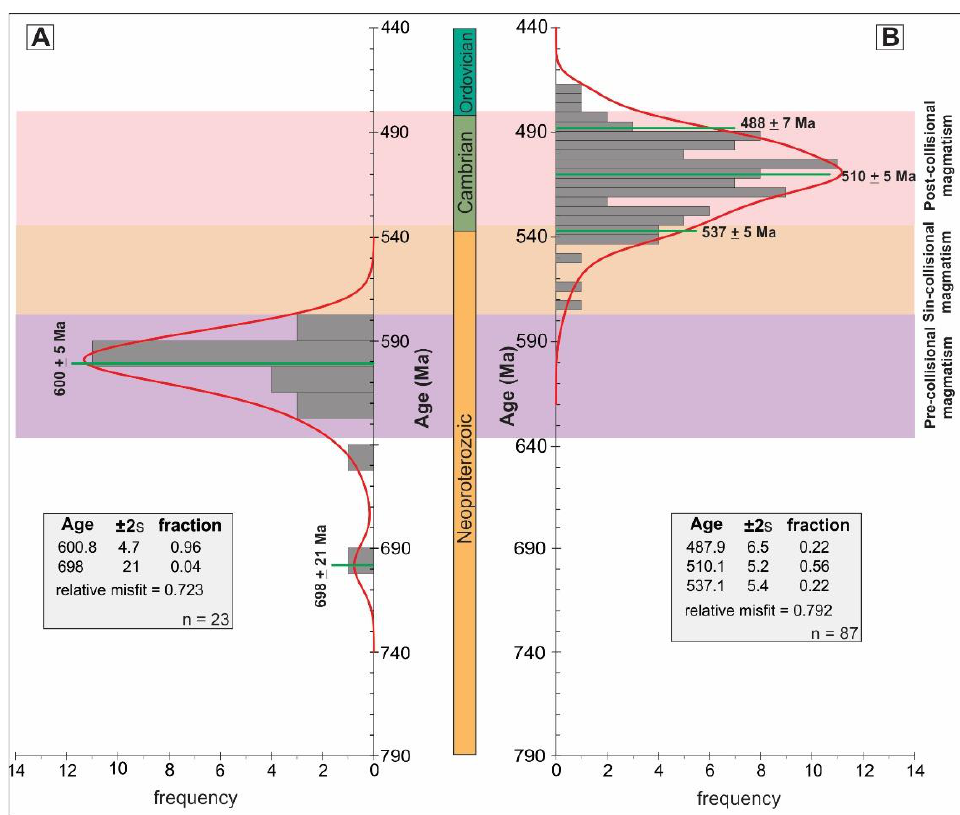
Figure 12. Histograms with the ages obtained for the Muniz Freire orthogneiss in samples: ( A ) SAIC- 02 and SAIC-13 and; ( B ) for the ages obtained in samples SAIC-06.A, SAIC-07.A, SAIC-09, SAIC- 10.A, SAIC-10.B, SAIC-12. The age intervals of the pre-, sin and post-collisional stages of the Araçuaí orogen [37] were plotted for comparison with the ages obtained in this work. orogen [37] were plotted for comparison with the ages obtained in this